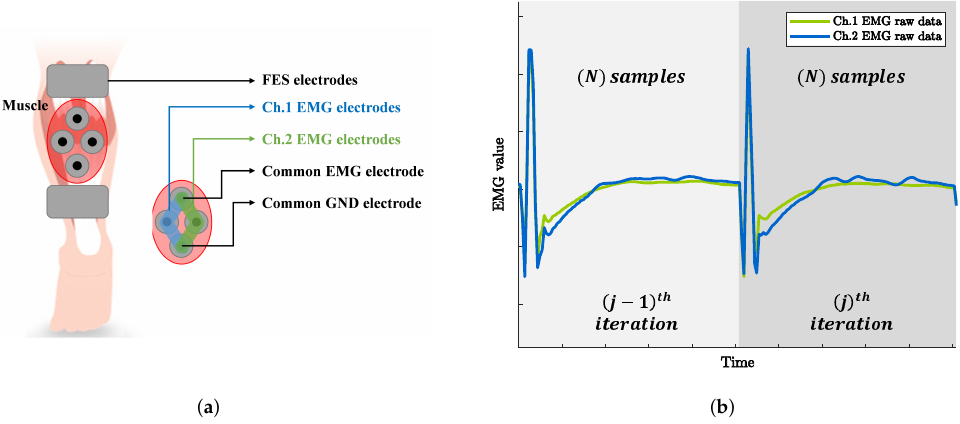
Figure 5. Dual-channel EMG data acquisition system: ( a ) Electrode attachment positions and ( b ) example of raw EMG data recorded from each EMG channel under electrical